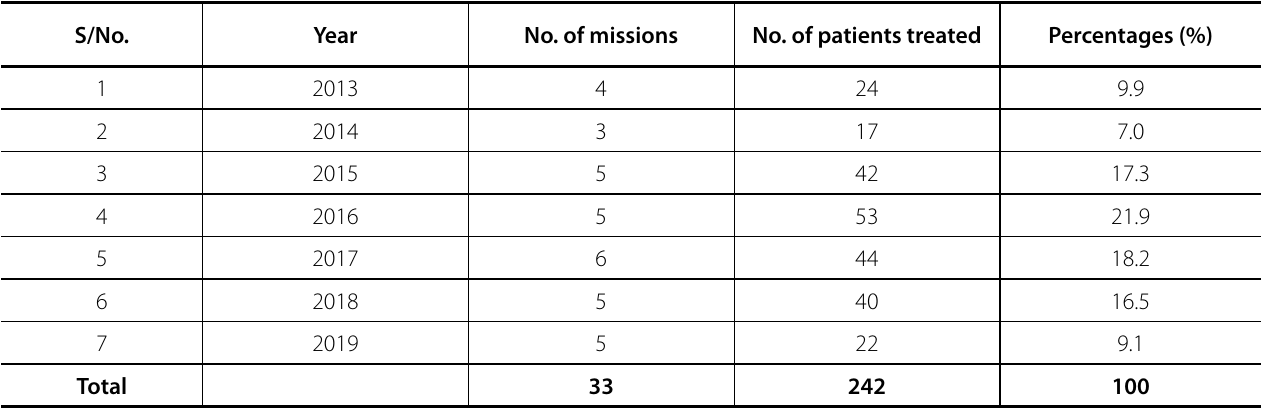
Table 1 . Seven years of foreign cardiac missions at the National Cardiothoracic Center of Excellence, University of Nigeria Teaching Hospital, Enugu, Nigeria. S/No.